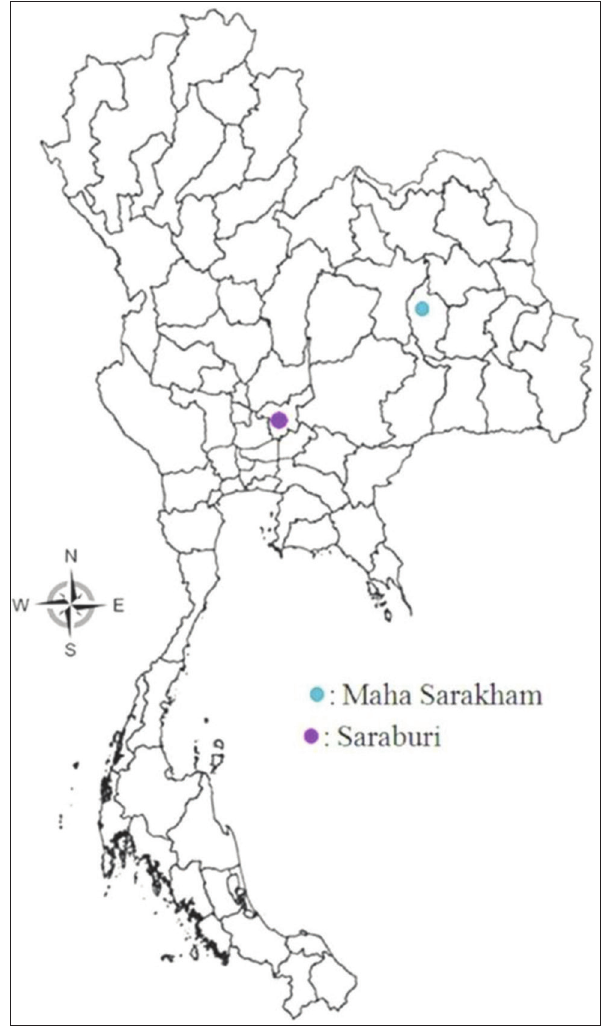
Figure-1: Study areas, the color points indicated the areas of sample